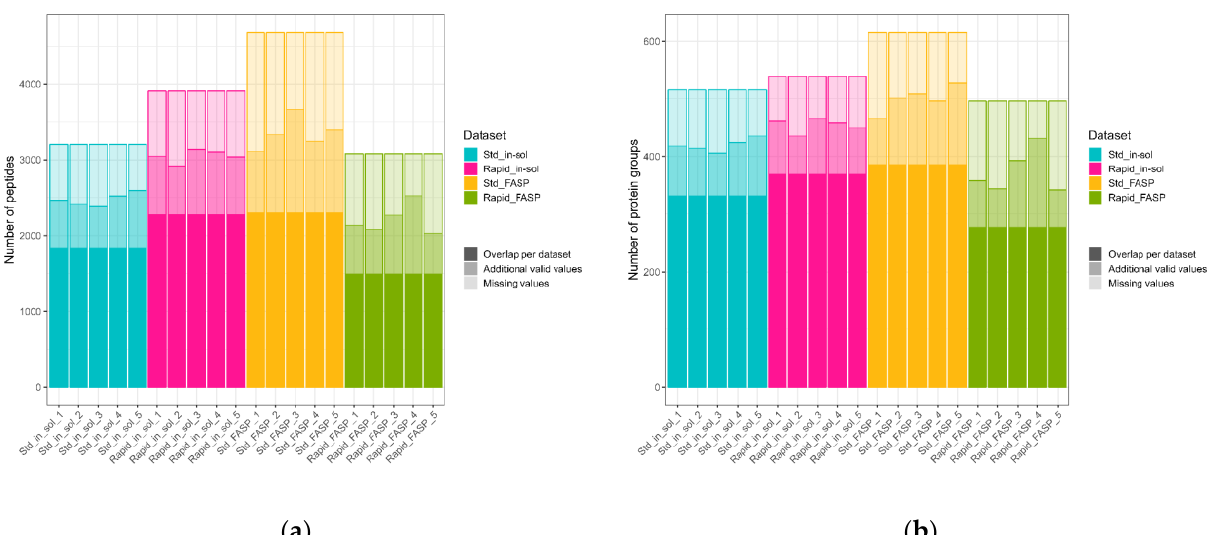
Figure 8. Number of quantified peptides and PGs and data completeness. Peptides ( a ) and PGs ( b ) were quantified by intensity using MaxQuant. In a dark tint, the number of consistent identifications for the corresponding dataset (overlapping for five replicates) is displayed. The dark tint and the one level lighter tint together indicate the total number of identifications in a sample. The lightest tint corresponds to the missing values in a sample. The highest data consistency was detected for the standard FASP and rapid in-solution digestion datasets. The lowest data consistency and the least reproducible results containing the most missing values were obtained for rapid